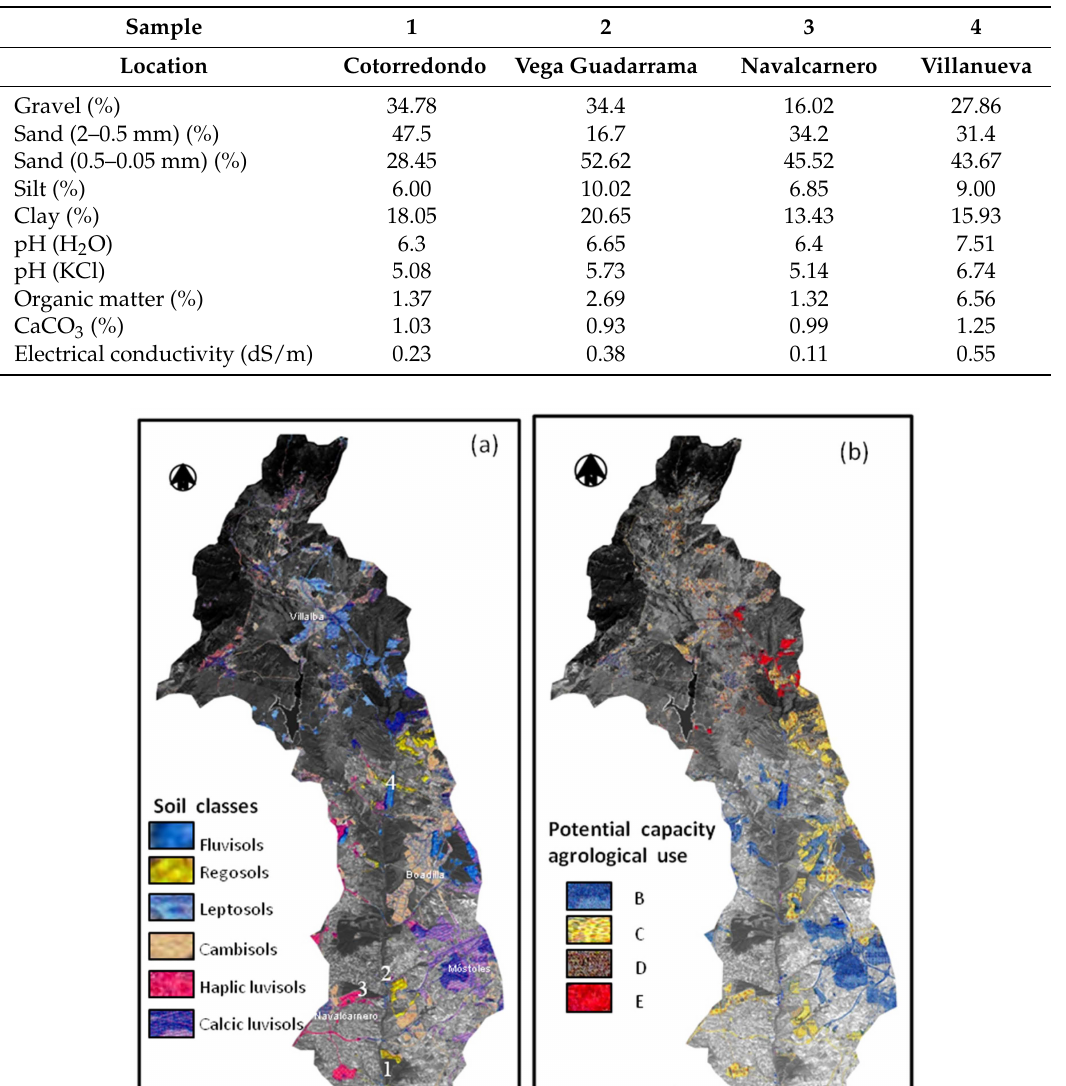
Table 3. Analytical soil data for four surface soil horizons in the Guadarrama Basin.